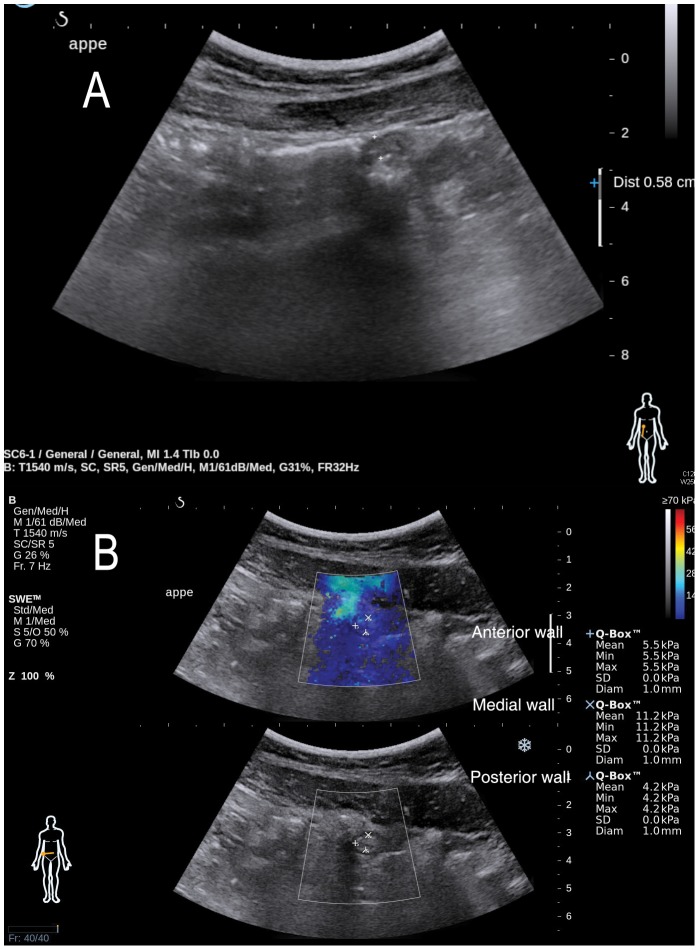
Gray-scale ultrasonography and shear wave elastography in a 24-year-old male patient with no appendicitis.A. Gray-scale ultrasonography was 5.8 mm in diameter. No echogenicity of periappendiceal fat or appendiceal wall thickening were noted. B. Elastic modulus scales (mean Q-Box) by shear wave elastography were 5.5, 11.2, and 4.2 kilopascal (kPa) in the anterior, medial, and posterior wall of the appendix, respectively. The highest elastic modulus scale (11.2 kPa) was selected for analysis. The modified Alavarado score in this patient was 5, and computed tomography showed a smaller diameter (<6 mm), no enhancement of periappendiceal fat, and the absence of appendiceal wall thickening. This patient was diagnosed with terminal ileitis and recovered without surgical intervention.